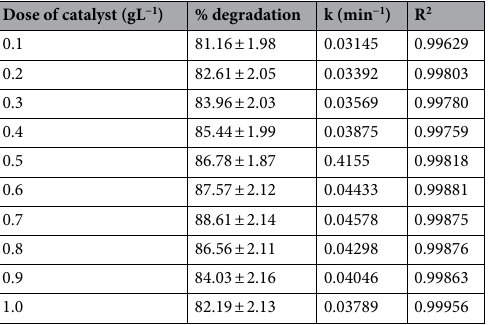
Table 2. Photodegradation chart of esomeprazole over In 2 O 3 /MoS 2 /Fe 3 O 4 at different catalyst doses.